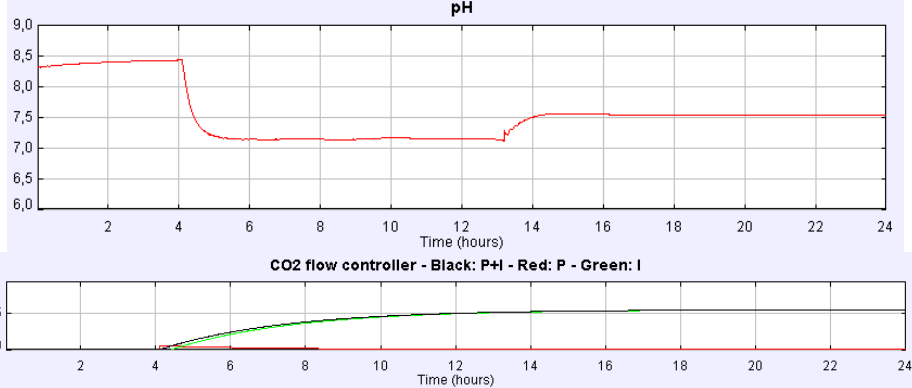
Figure 8. pH and controller signals evolution for the CO time-based mode controller.